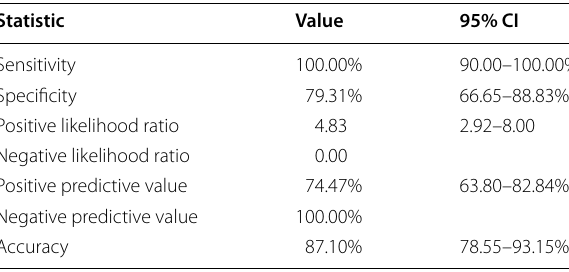
Table 4 Showing the accuracy measures of method 1